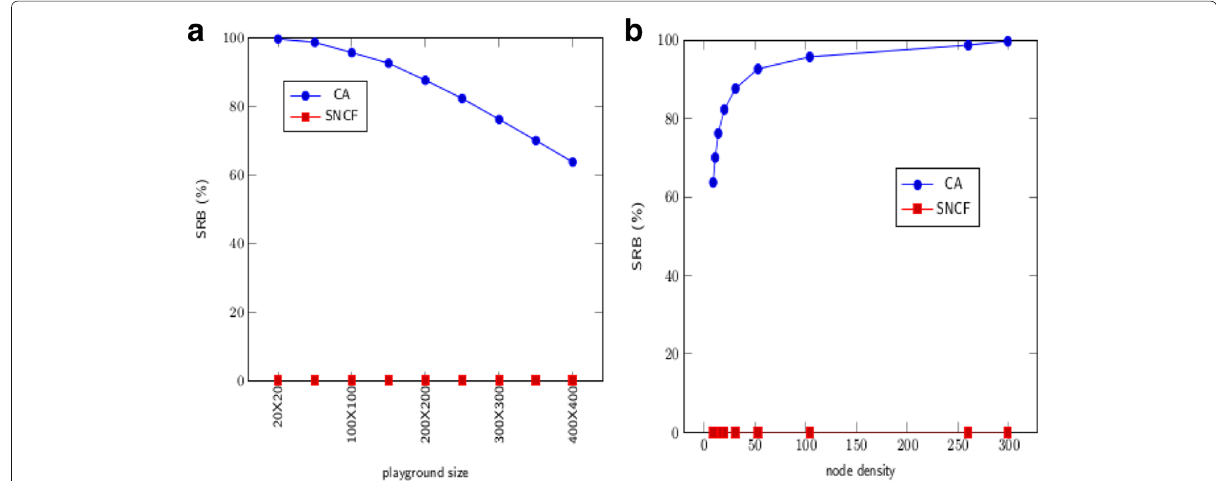
Fig. 22 Saved rebroadcasts (SRB) for CA and SNCF protocols for a 300-node network. a Against playground size. b Against node